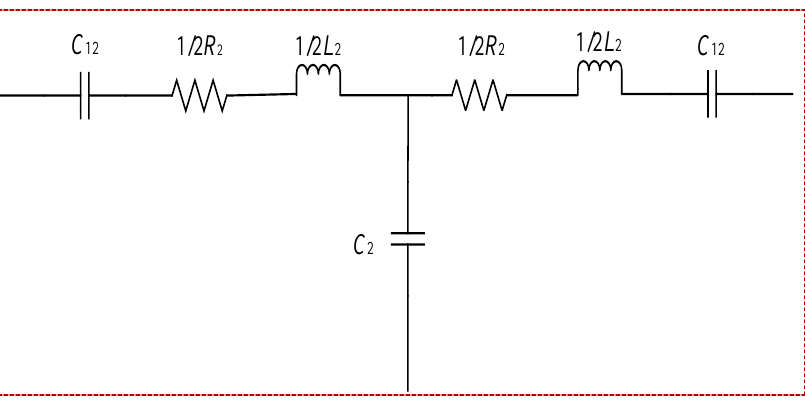
Figure 4. Equivalent model of the neutral zone.